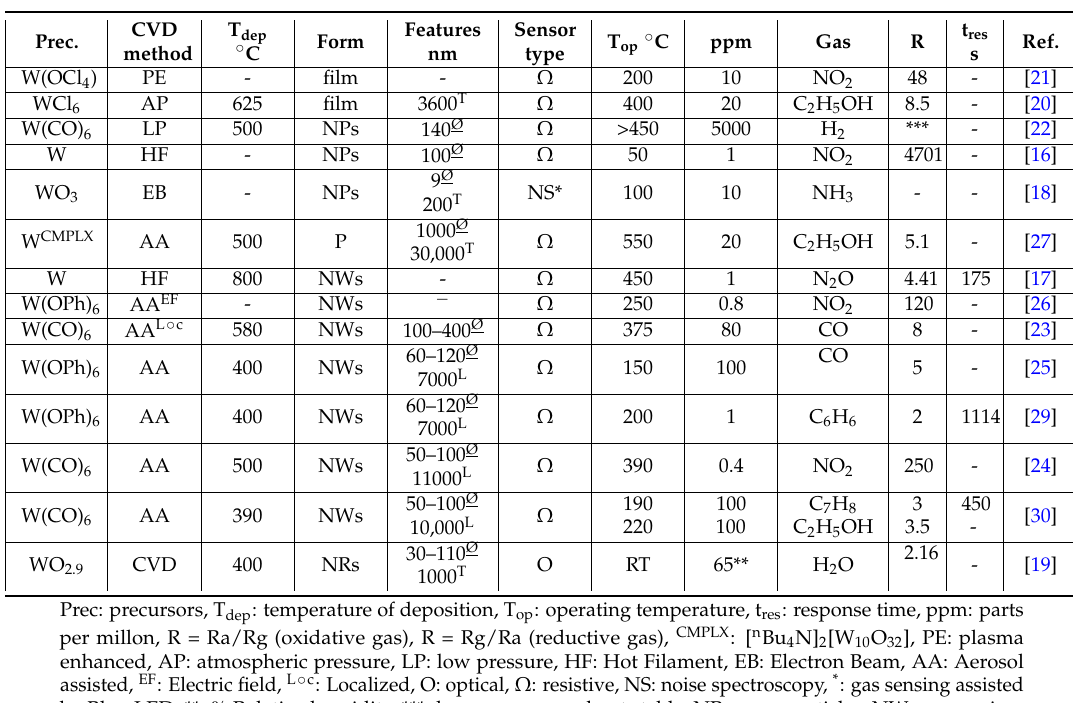
Table 1. Summary of the features and sensing properties reported for chemical vapour deposited tungsten oxide.